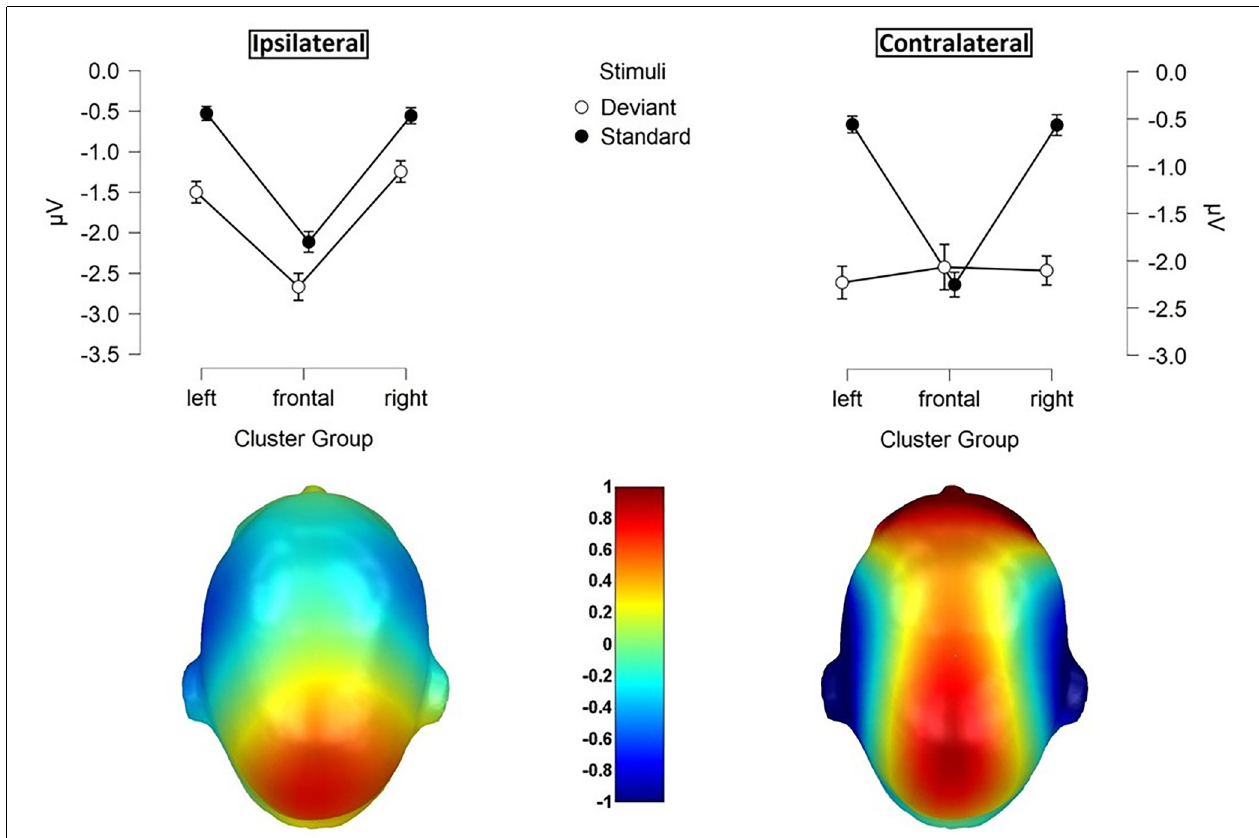
FIGURE 4 | Mean values ( µ V) of N140 amplitudes and SE. Illustration of the three-way-interaction: Laterality x Cluster Group x Stimuli, with topographic difference plots (100–180ms). Bottom left: Ipsilateral Deviants—Ipsilateral Standards. Bottom right: Contralateral Deviants—Contralateral Standards.